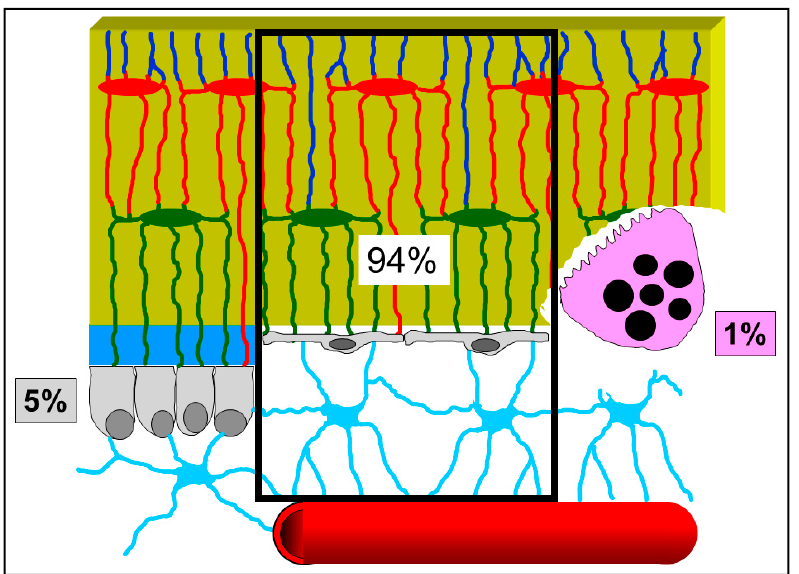
Figure 6. Schematic drawing showing the percentage of the various bone cells present in the bone resting phase: 94% BBCS, 5% osteoblasts, and 1% osteoclasts (data from Parfitt [34]). See text for explanation.